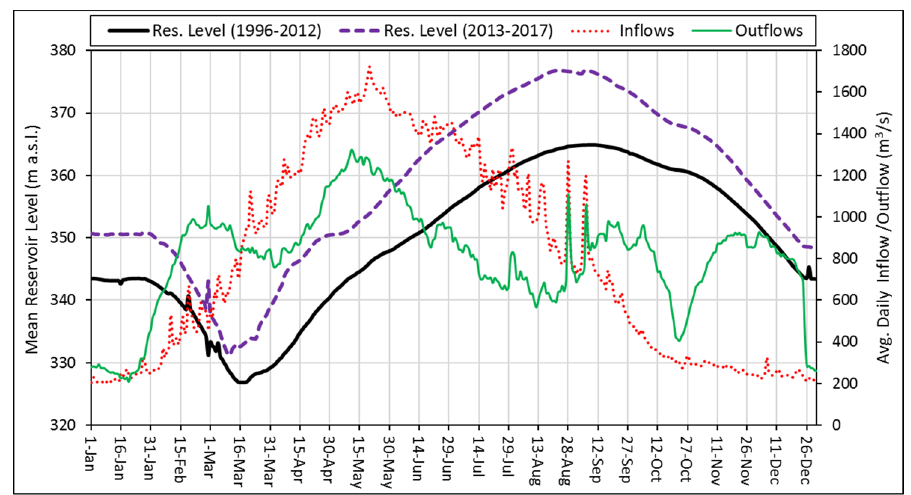
Figure 7. Daily mean reservoir inflow/outflow and level before and after the Mangla upraising.